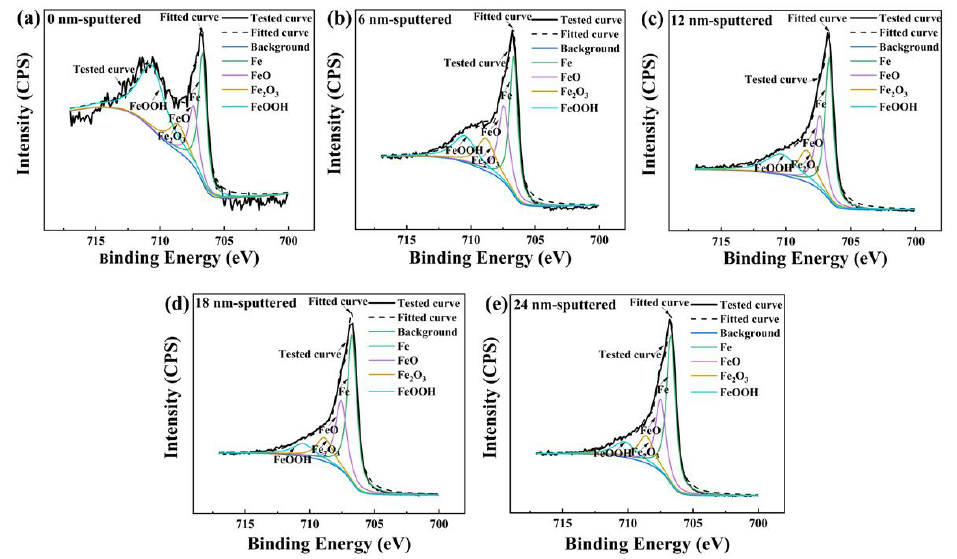
Figure 9. XPS depth analysis of Fe 2p 3/2 at ( a ) 0 nm, ( b ) 6 nm, ( c ) 12 nm, ( d ) 18 nm, and ( e ) 24 nm of the passive film of the rebar matrix.